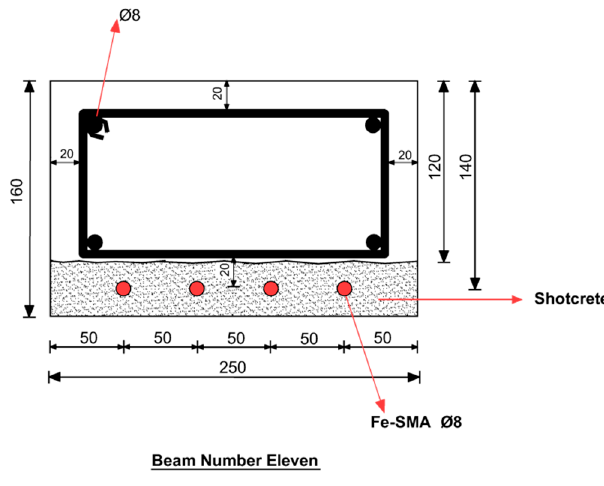
Figure 1. Cross-sections of Beams 9, 10 and 11 (in mm) [14].